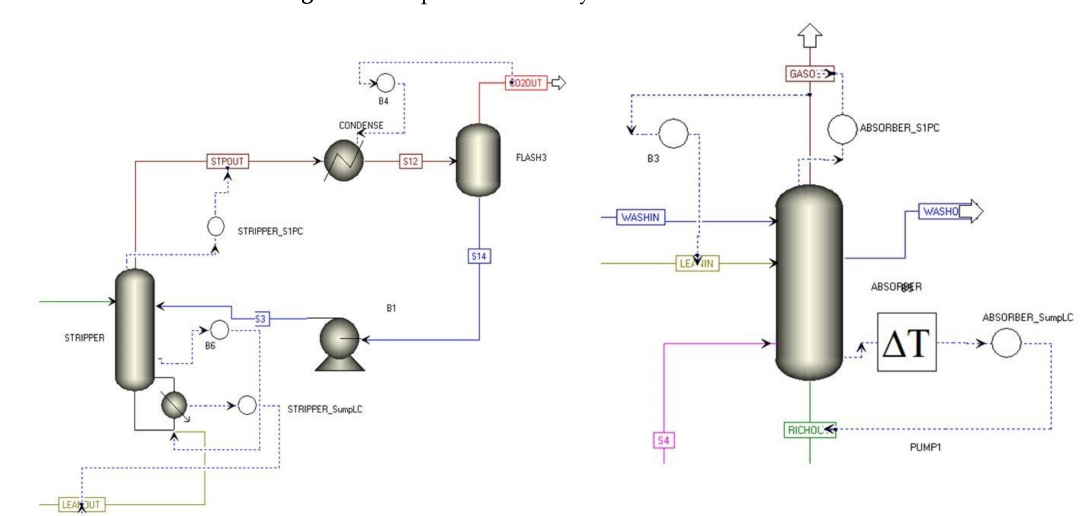
Figure A4. Aspen Plus ® steady-state model flow sheet.